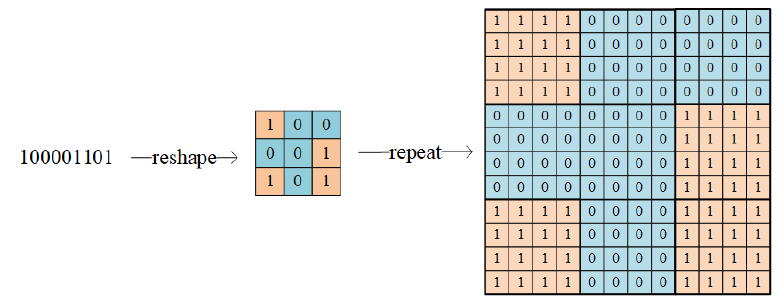
Figure 8. An example of expanding message.